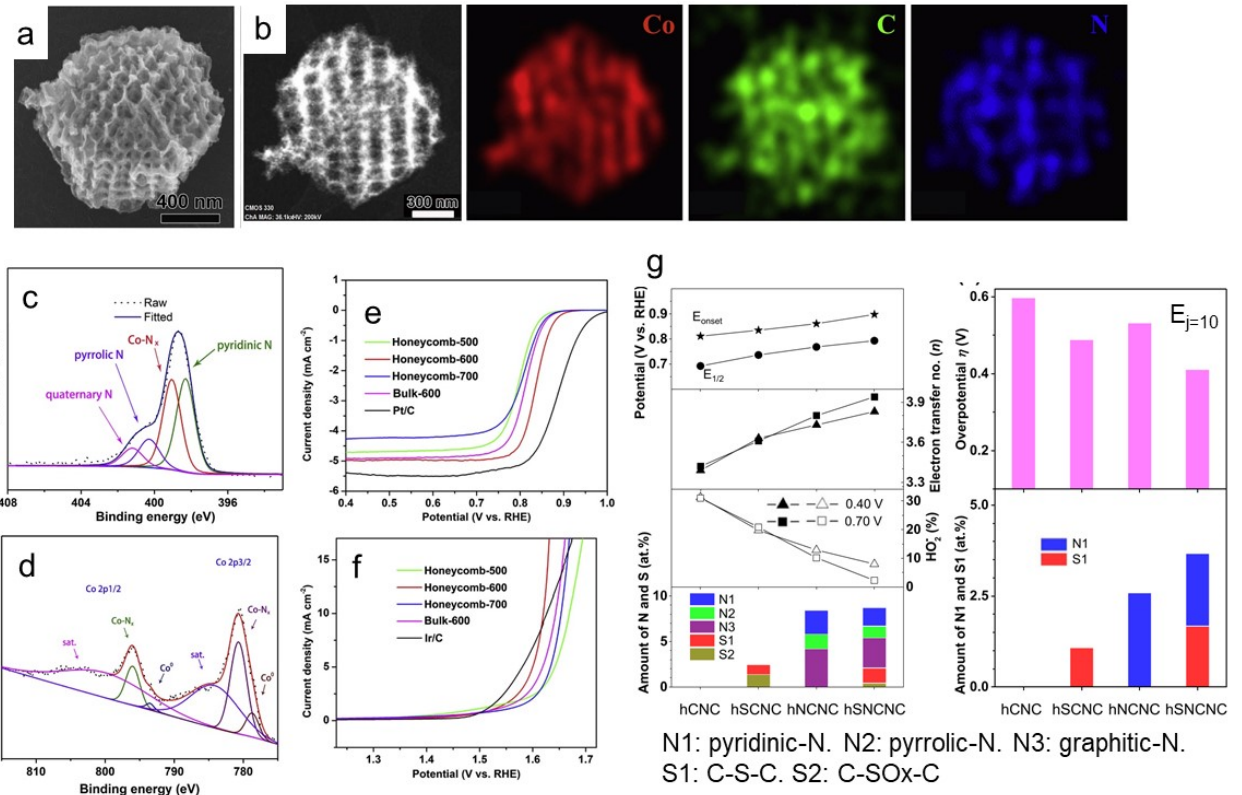
Figure 3. Relationship between the structures and electrochemical properties of typical catalysts. ( a ) SEM image; ( b ) energy − dispersive X − ray mapping results; ( c , d ) N 1s spectrum and Co 2p spectrum; ( e , f ) ORR and OER LSV curves of Honeycomb − 600 (reproduced from [38], copyright 2020, Elsevier); ( g ) ORR − and OER − related indexes versus amount of highly active N and S sites in hCNC, hSCNC, hNCNC, and hSNCNC (reproduced from [52], copyright 2020).